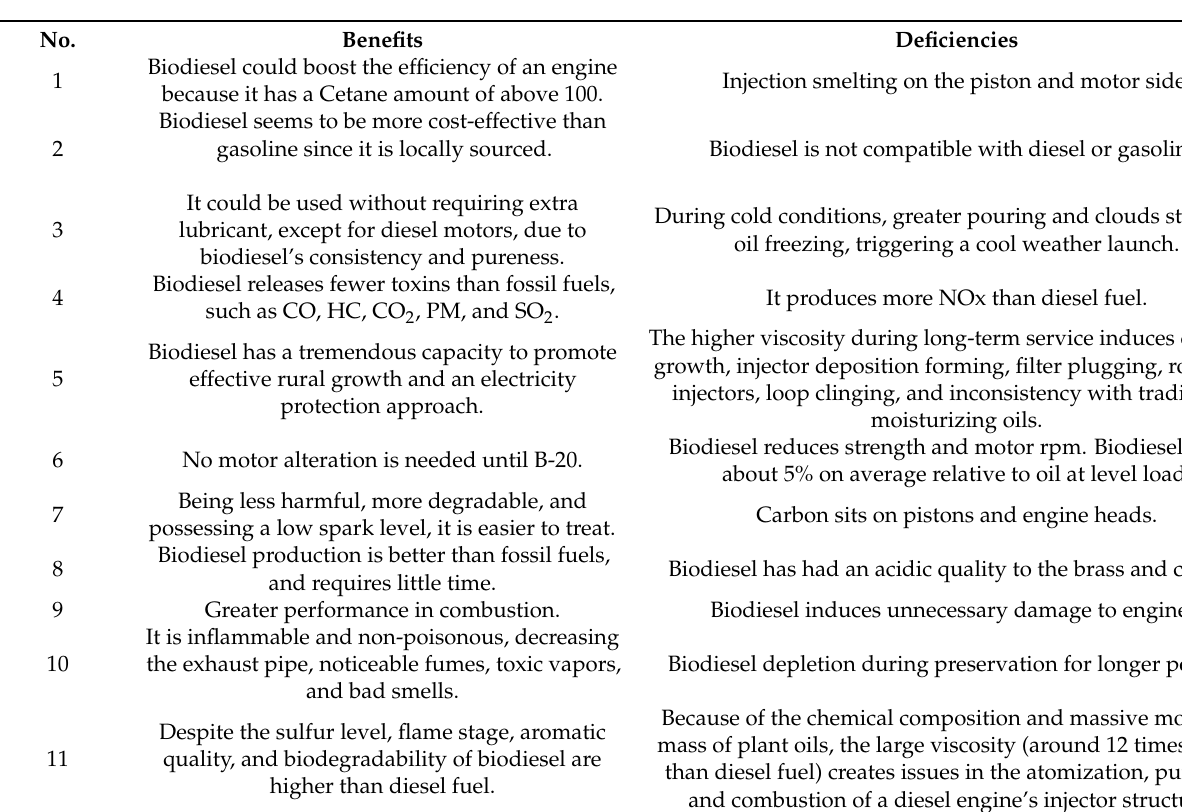
Table 2. Review of benefits and deficiencies of biodiesel